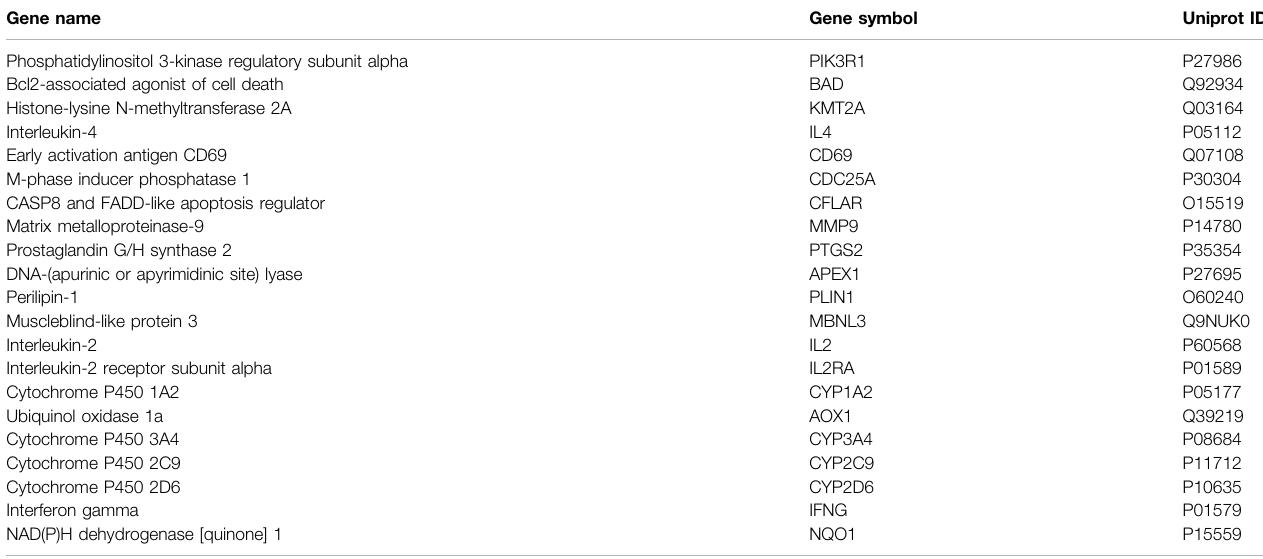
( Figure 2B ). The above 84 common targets were entered into